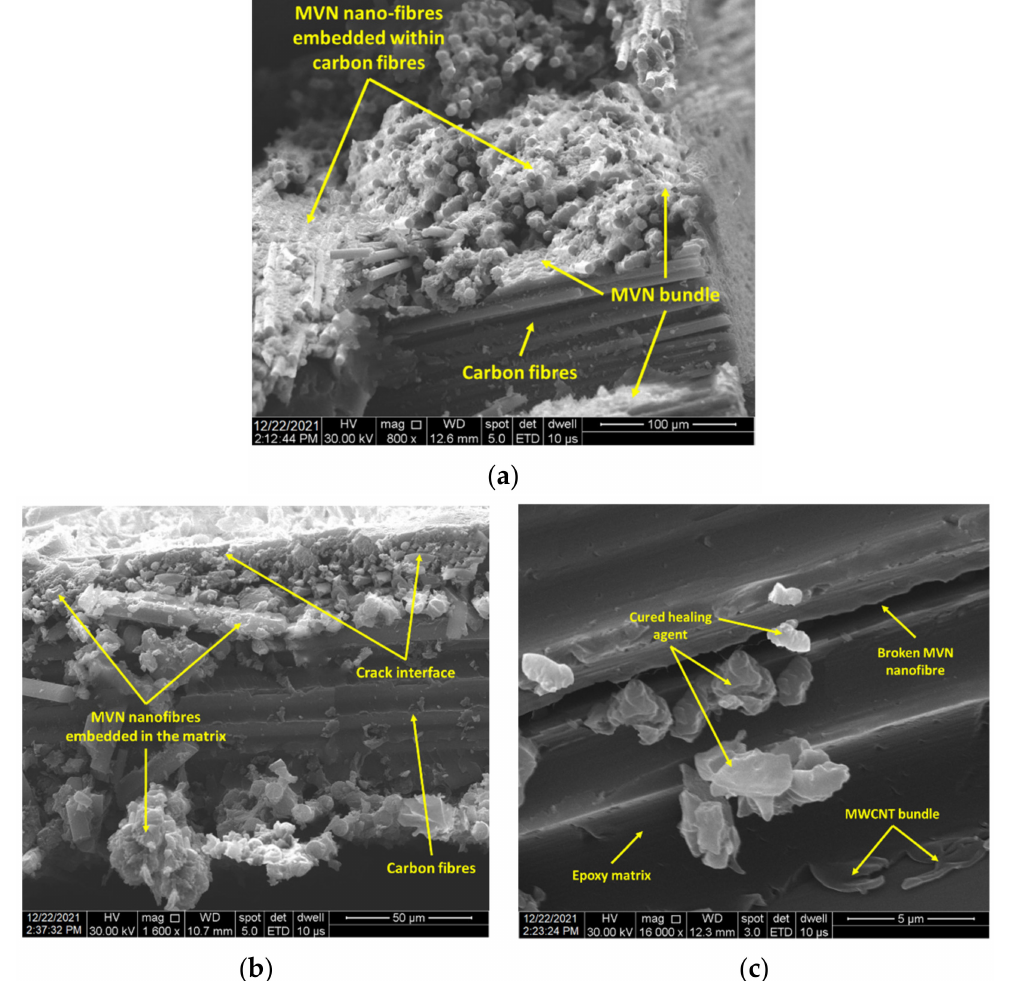
Figure 16. SEM analysis of CFRP specimens containing MVN and MVN/MWCNT at different magnification levels, at ( a ) 800 × , ( b ) 1600 × , ( c ) 16,000 ×